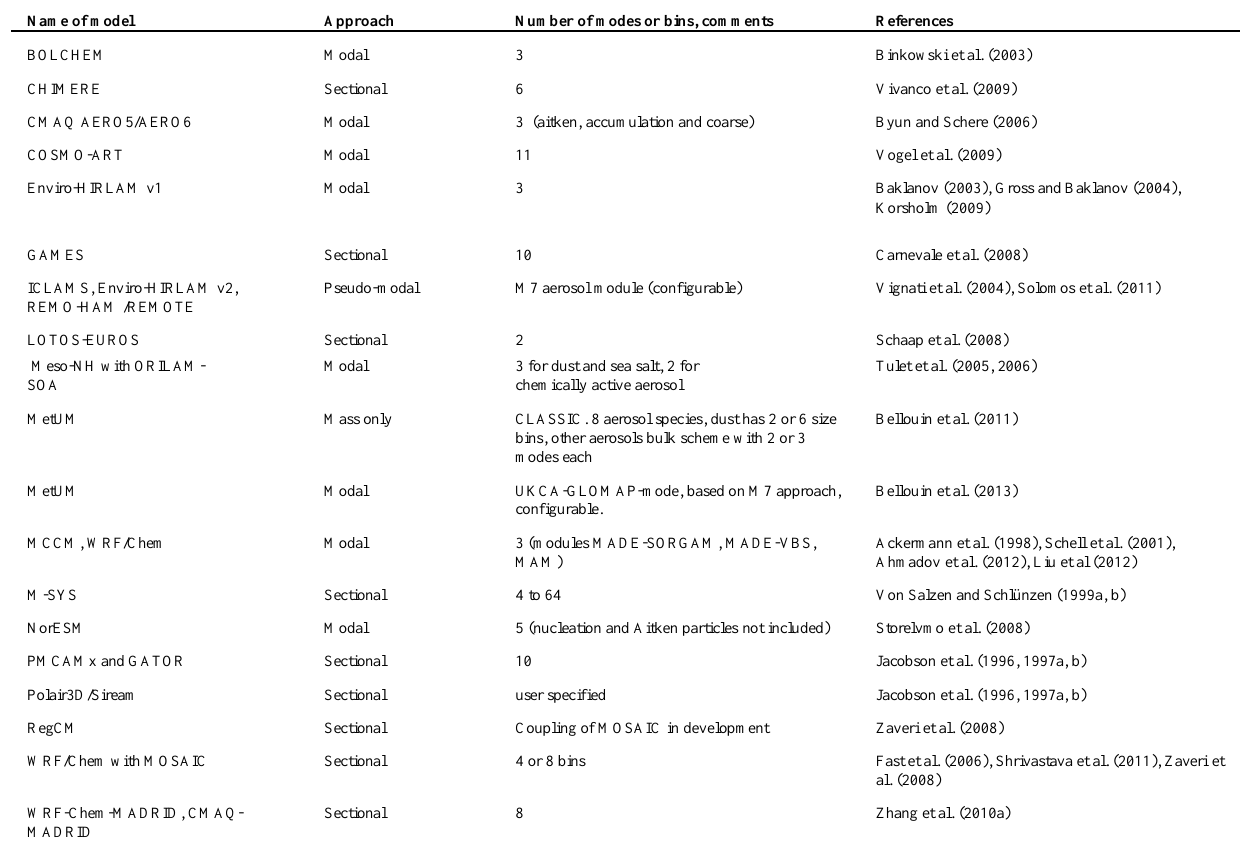
Table 7. Aerosol physics approaches applied in different models.